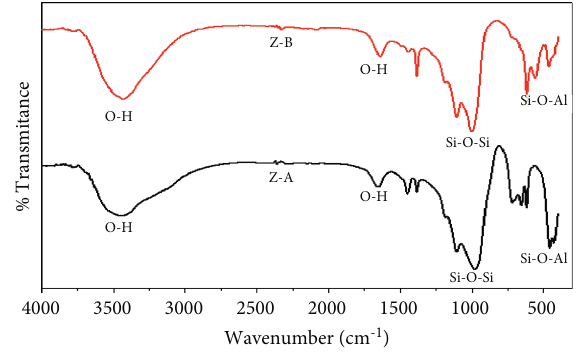
Figure 3: FTIR spectra of Z-A and Z-B.